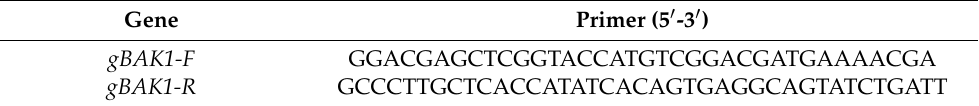
Table 2. Cloning primer sequences for BAK1 amplification from genomic DNA.